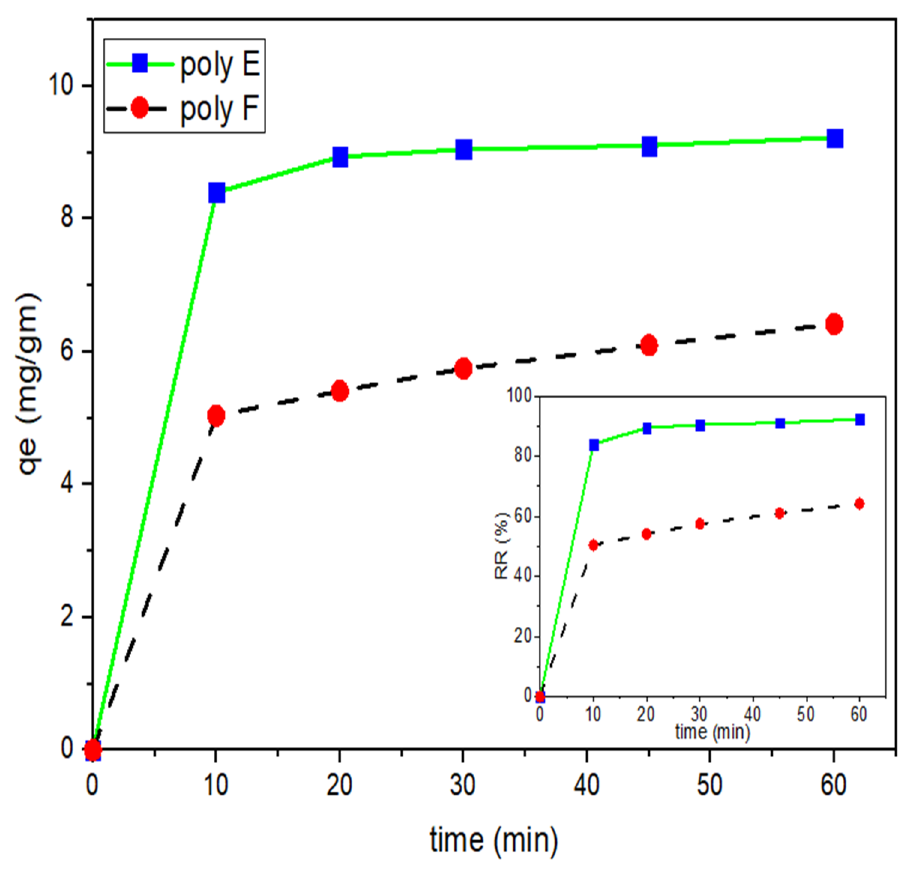
Figure 9. Effect of contact time on q t of both PAA and OP-PAA for MB adsorption. Experimental conditions were: MB concentration 100 mg/L; adsorbents hydrogel dose 250 mg in 25 mL; pH 9 at RT. The experimental data were used to plot log(cid:4666)q (cid:2915) − q (cid:2930) (cid:4667) and t/q t against t , as shown in